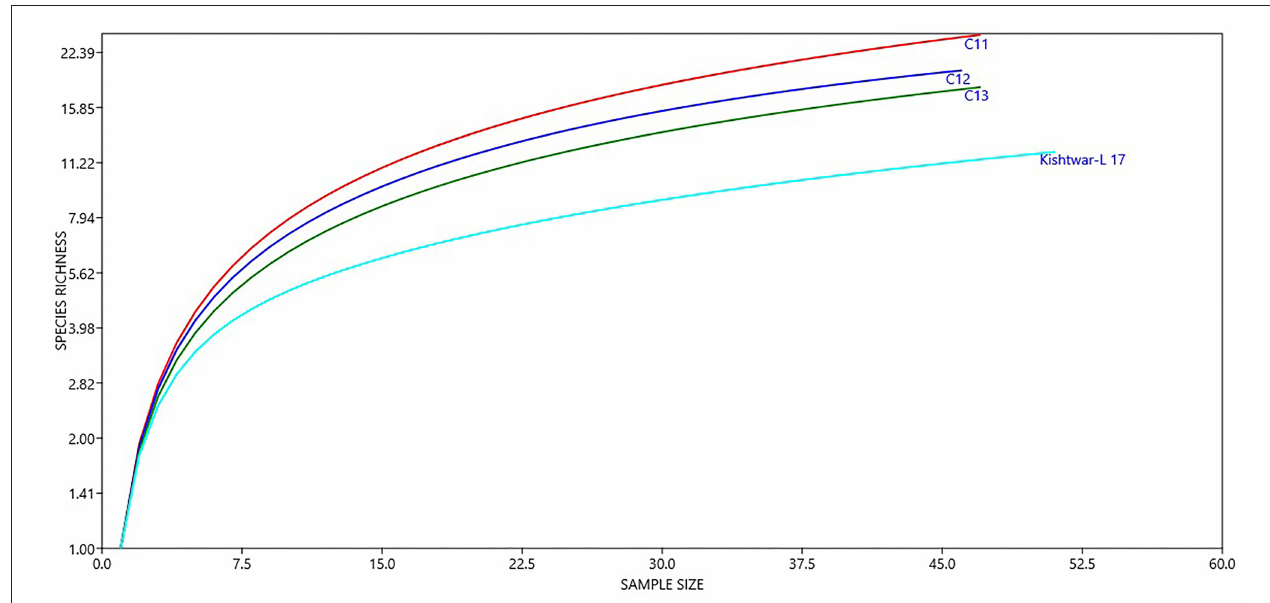
FIGURE 6 | Diversity of different genera in Kishtwar samples (C11, C12, C13, and Kishtwar-L 17). Presence of higher number of species in C11 indicates that it is more enriched than C12, C13, and Kishtwar-L